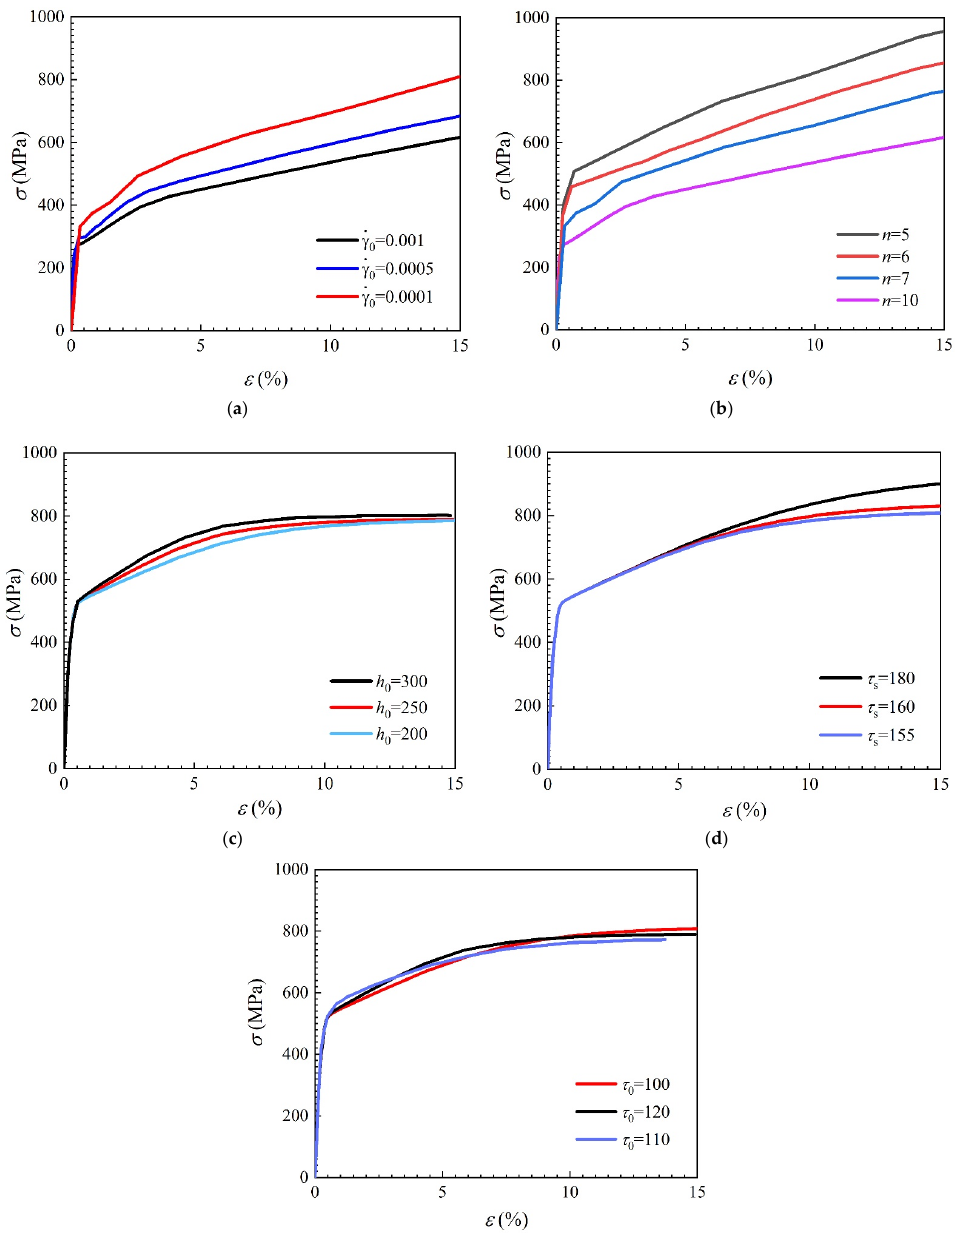
Figure 5. Comparison of the effects of various parameters on the mechanical properties of crystal. ( a ) Reference shear rate 0 γ  ; ( b ) rate sensitive parameter n ; ( c ) Initial hardening modulus h 0 ; ( d ) Saturated critical shear stress s τ ; ( e ) Initial flow stress 0 τ